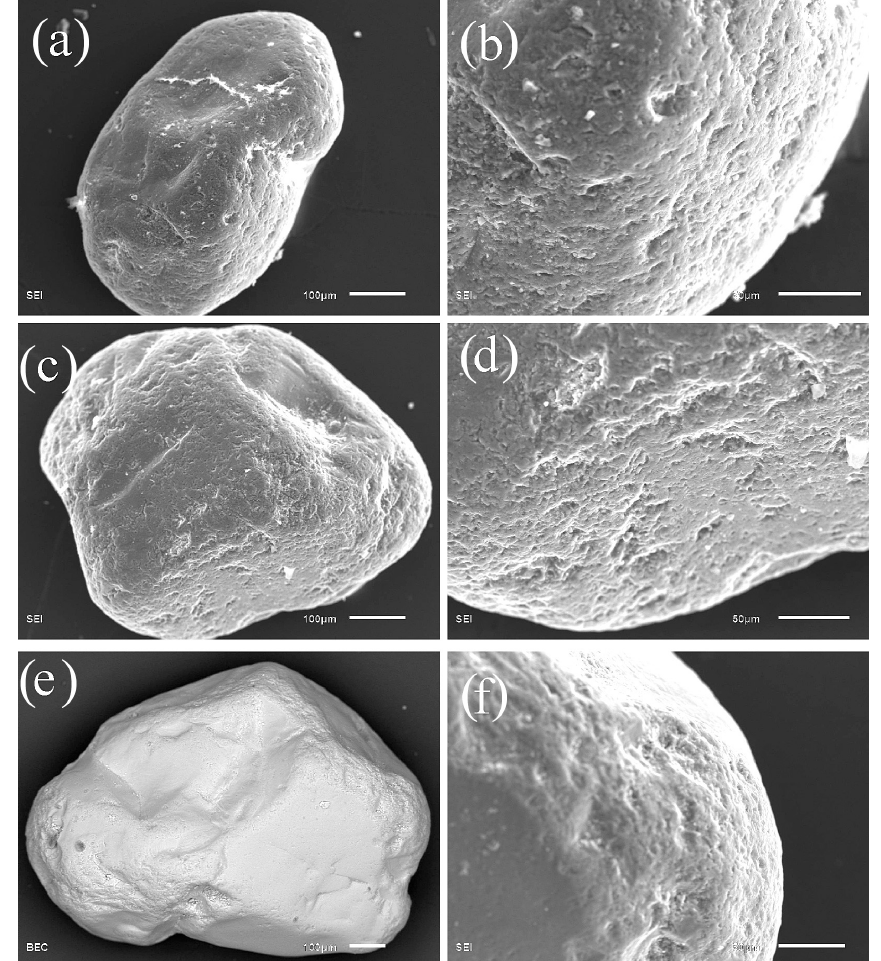
Figure A10. SEM photos of quartz grains from the section NS-22. (a, b) Glossy grain with a fine-pitted surface; (c, d) glossy grain with a fine-pitted surface; (e, f) glossy grain with fine pits on the protruding parts of the